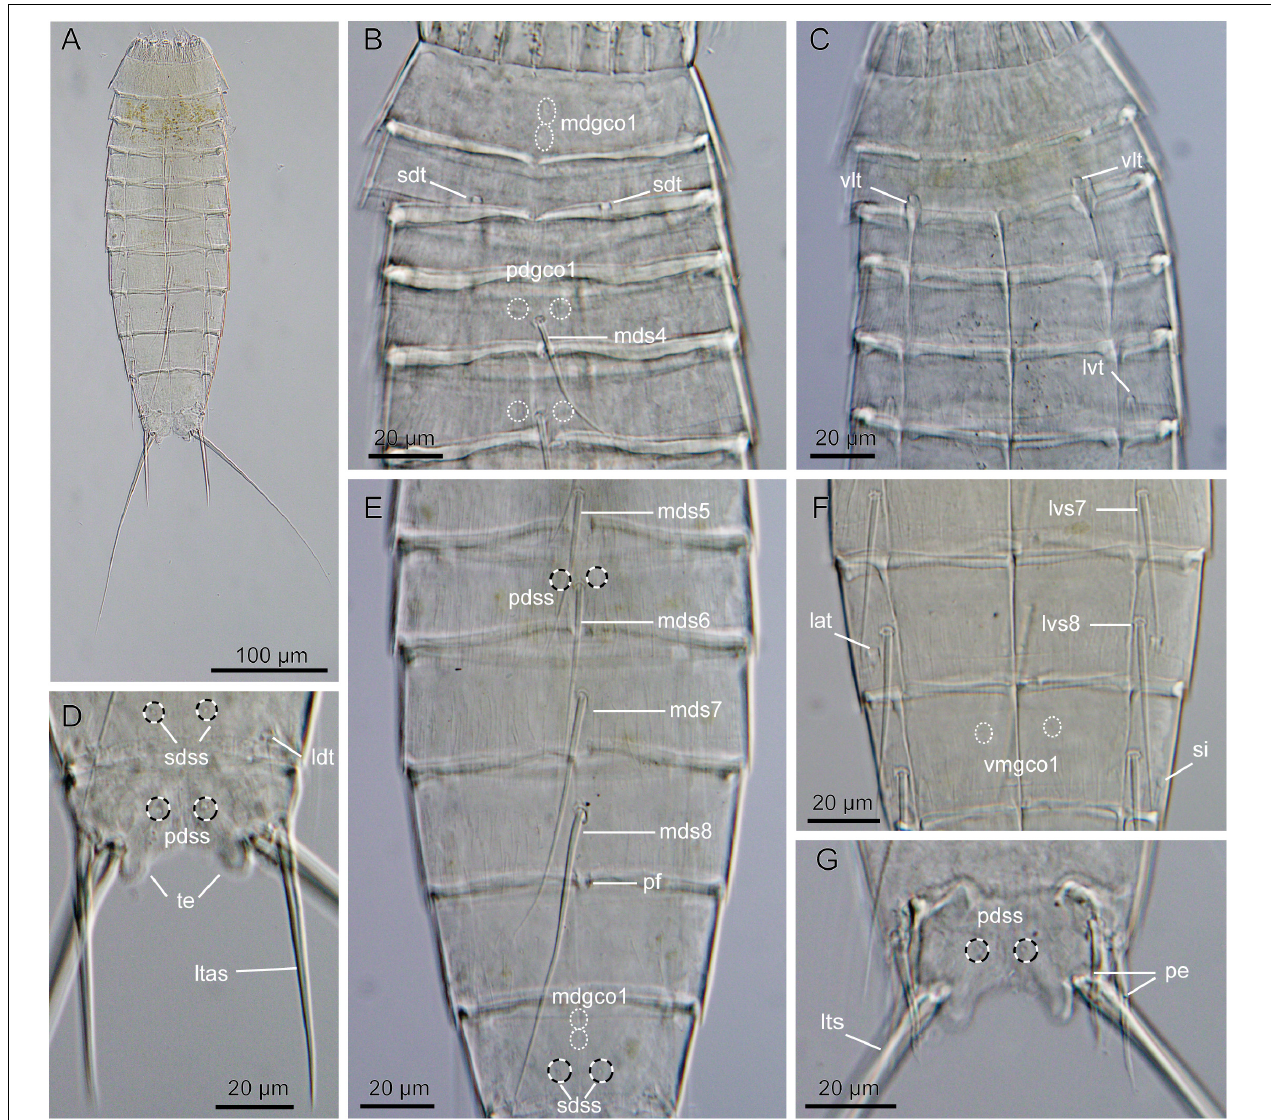
FIGURE 3 | Light micrographs showing overview and details of Echinoderes mamaqucha sp. nov. (A,D–F) Female holotype (NHMD-872635). (B,G) Male paratype (NHMD-872636). (C) Female paratype (NHMD-872641). (A) Ventral overview. (B) Segments 1 to 5, dorsal view. (C) Segments 1 to 5, ventral view. (D) Segments 10 to 11, dorsal view. (E) Segments 5 to 10, dorsal view. (F) Segments 7 to 9, ventral view. (G) Segments 10–11, dorsal view. lat , lateral accessory tube; ldt , laterodorsal tube; lts , lateral terminal spine; ltas , lateral terminal accessory spine; lvs , lateroventral spine, followed by segment number; lvt , lateroventral tube; mdgco1 , middorsal glandular cell outlet type 1; mds , middorsal spine, followed by segment number; pdgco1 , paradorsal glandular cell outlet type 1; pdss , paradorsal sensory spot; pe , penile spine; pf , papillary flap; sdss , subdorsal sensory spot; sdt , subdorsal tube; si , sieve plate; te , tergal extension; vlt , ventrolateral tube; vmgco1 , ventromedial glandular cell outlet type